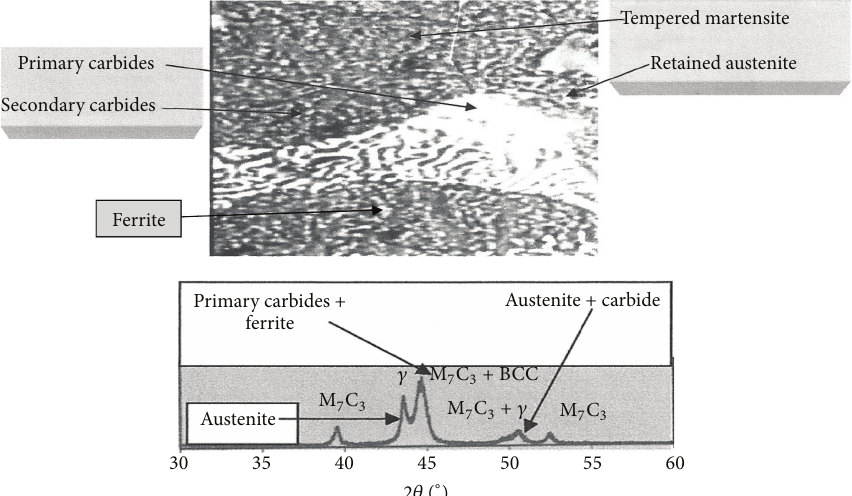
Figure 7: Typical microstructure of experimental steel after heat treatment, as revealed by X-ray diffraction [hardening 980 ∘ C-AC, tempering 600 ∘ C, 2